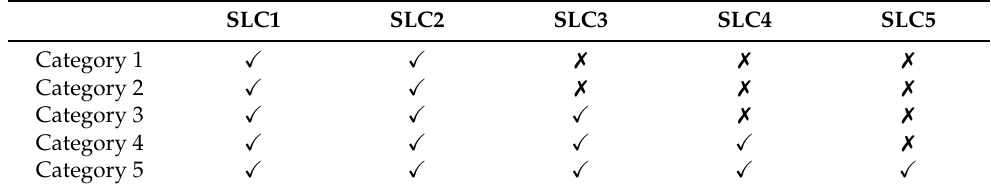
Table 11. Assigning SLCs to IoT